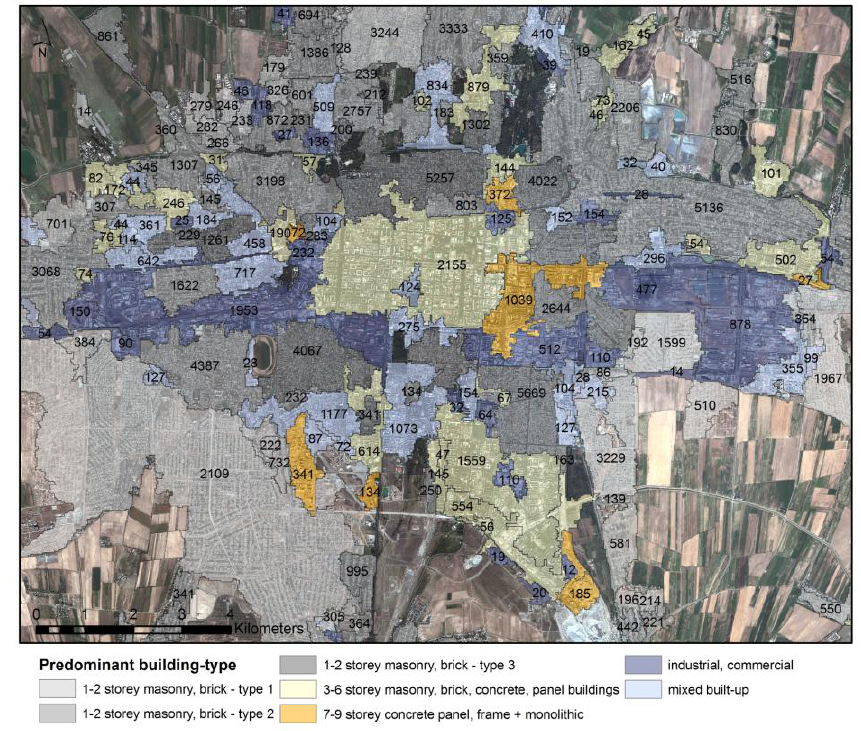
Figure 10. LULC classification of Bishkek showing the distribution of pre-dominant building types in 2009 (see Tables 1 and 4). The numbers are the estimated numbers of buildings per stratum.